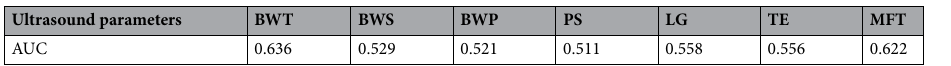
Table 4. Area under ROC curve for 7 ultrasound parameters. Meanings of abbreviations: BWT (Bowel wall thickness), BWS (Bowel wall stratification), BWP (Bowel wall perforation), PS (bowel peristalsis), LG (Limberg grade of the bowel wall vascularization), TE (existence of the homogeneous enhancement of the bowel wall), MFT (Mesenteric fat thickness).